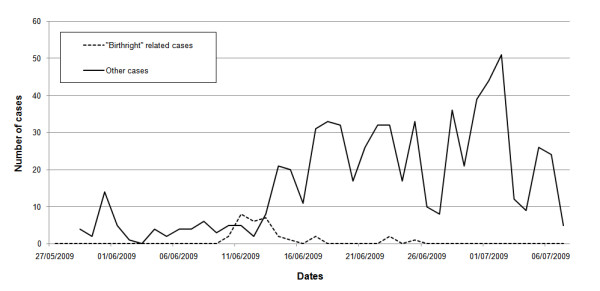
"Birthright" influence on spread. Influence of the group of young American students (from the "Birthright" project) on time series of swine flu cases in Israel. The dashed line shows all the cases that were either group members or identified themselves as being in contact with the "Birthright" group. The solid line displays the rest of the cases.